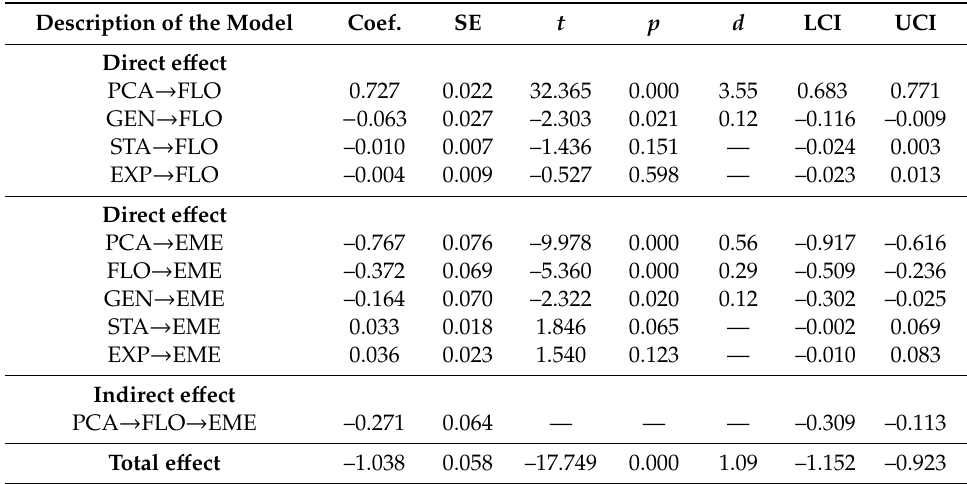
Table 2. Results of the mediation analysis of flourishing in the relationship between PsyCap and emotional